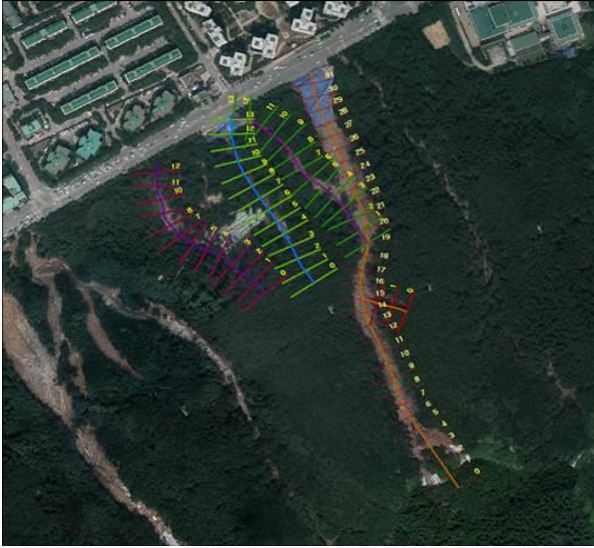
Figure 8. Extraction of longitudinal and cross-sectional